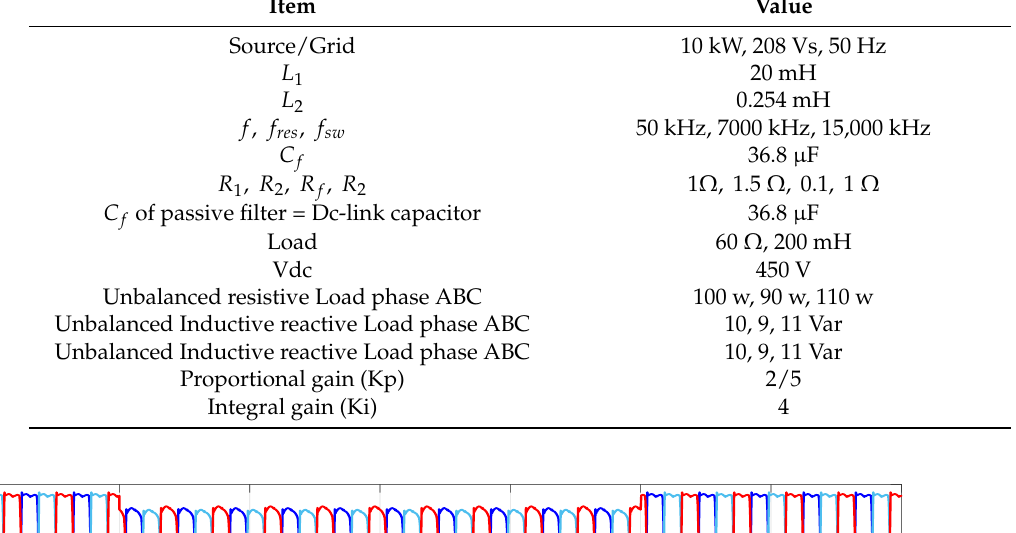
Table 3. Designed HPF parameter values and considered test loads.